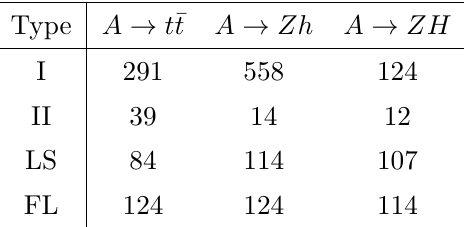
Table 14 . Number of parameter points available for the analysis in the individual OS decay channels of the pseudoscalar Higgs boson A ( H is